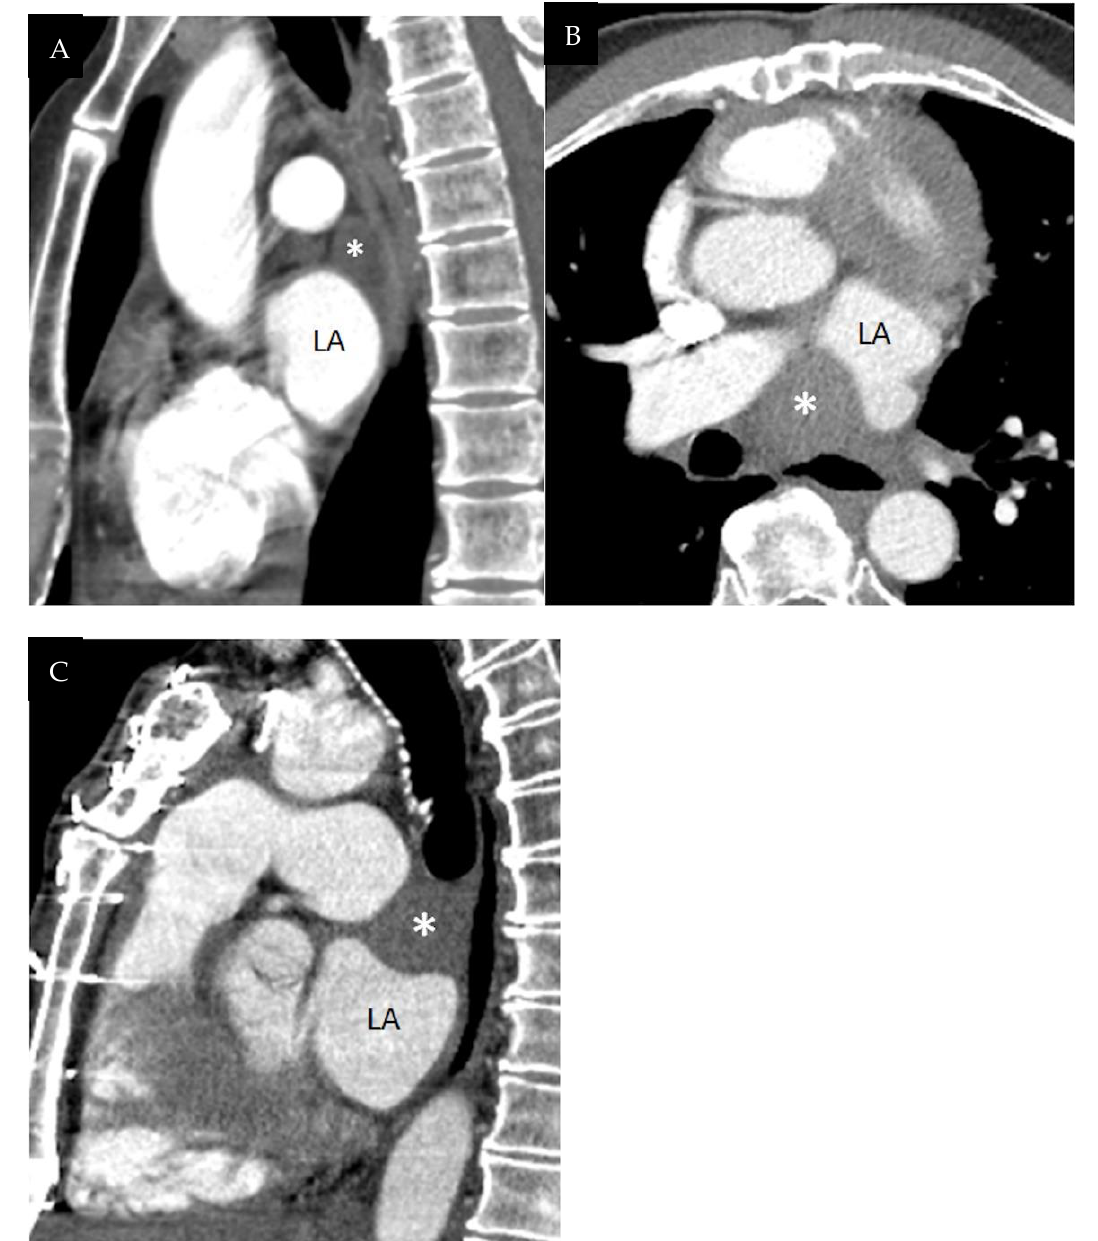
Figure 7. Fluid versus metastatic disease in the oblique sinus. ( A ) Sagittal reformation shows a normal oblique sinus (*) with no mass effect on the left atrium. LA = left atrium. Contrast-enhanced axial CT ( B ) and sagittal reformation ( C ) in a 61 year-old man with thymoma depict enhancing soft tissue (*) representing pericardial metastatic disease in the oblique sinus. Note mild mass effect on the upper aspect of the left atrium in ( C ). Soft tissue attenuation, enhancement, and mass effect are characteristics of adenopathy or metastatic disease in pericardial recesses. Reprinted from Shroff, G.S. et al. Pitfalls in oncologic imaging of the pericardium on CT and PET/CT [4].